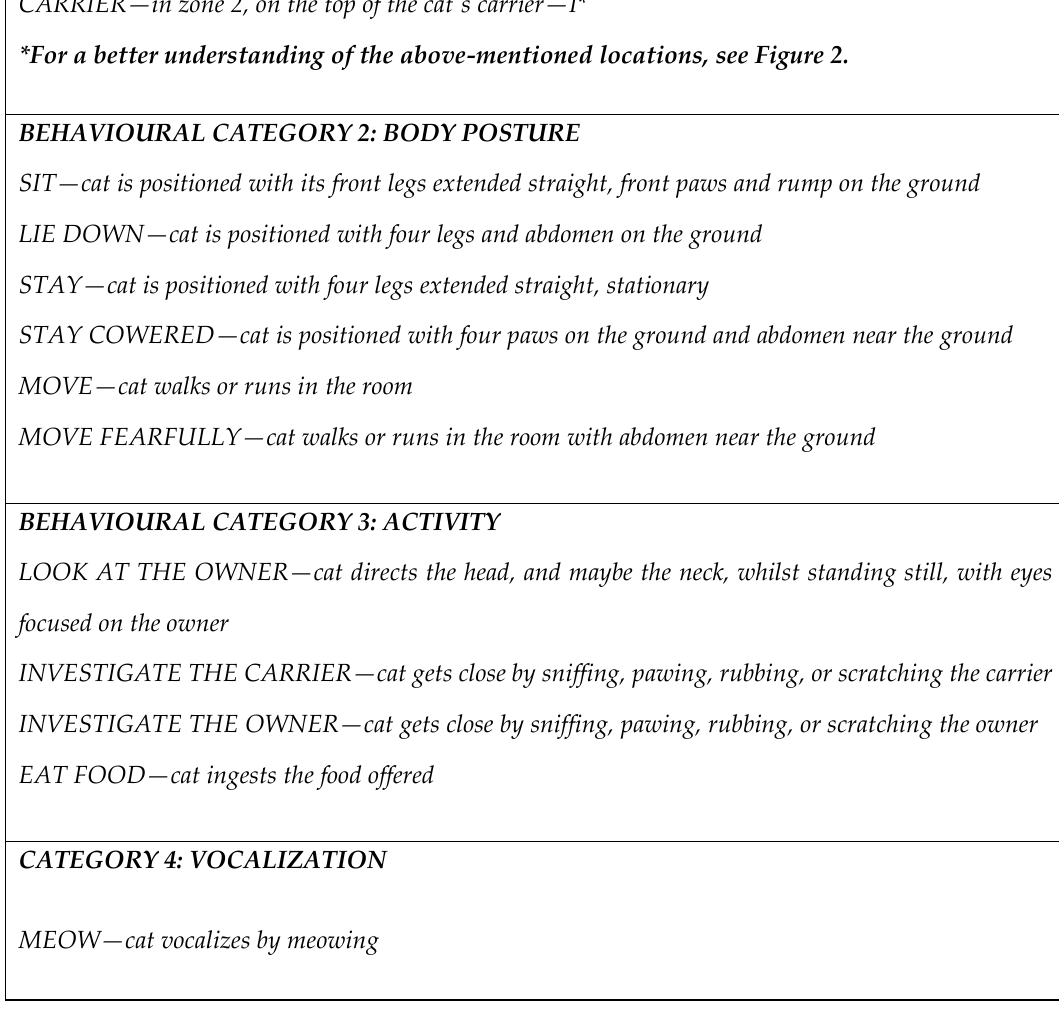
Figure 1. Behavioural categories and defined behaviours for video analysis.